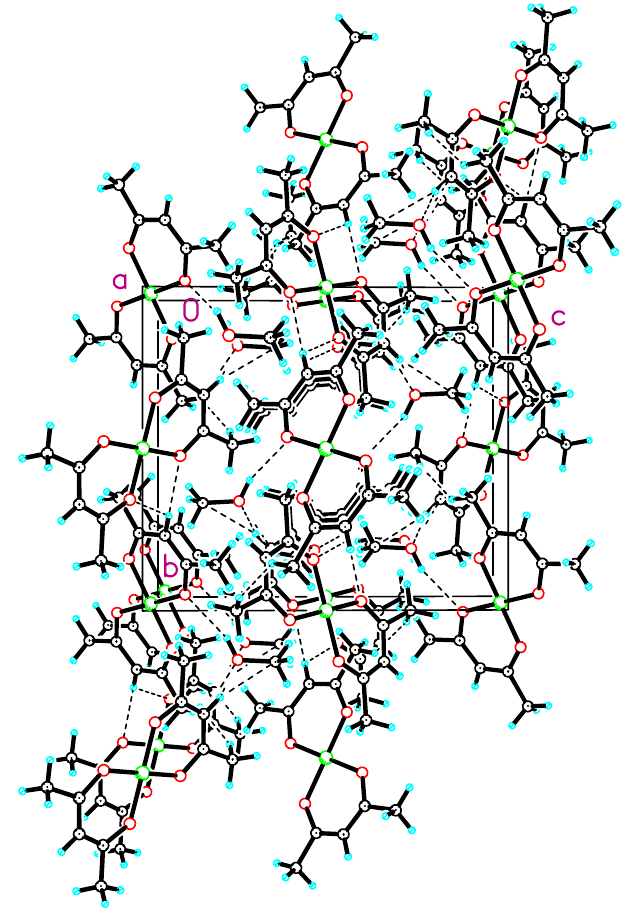
Figure 2. The crystal packing for [Ni(acac) showing intermolecular O-H···O hydrogen bonds as dashed lines.